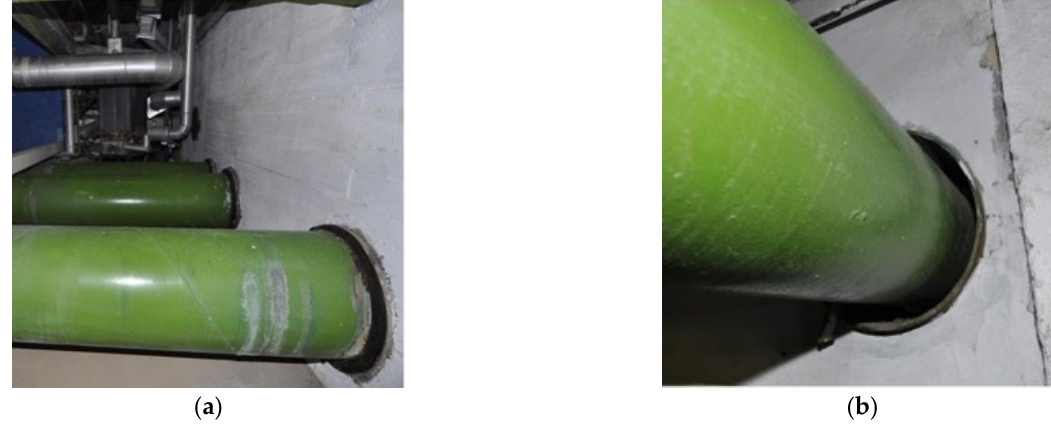
Figure 1. ( a ) Intersection of the pipelines of the emergency service water system with the wall of main building; ( b ) gap between the wall and pipe.